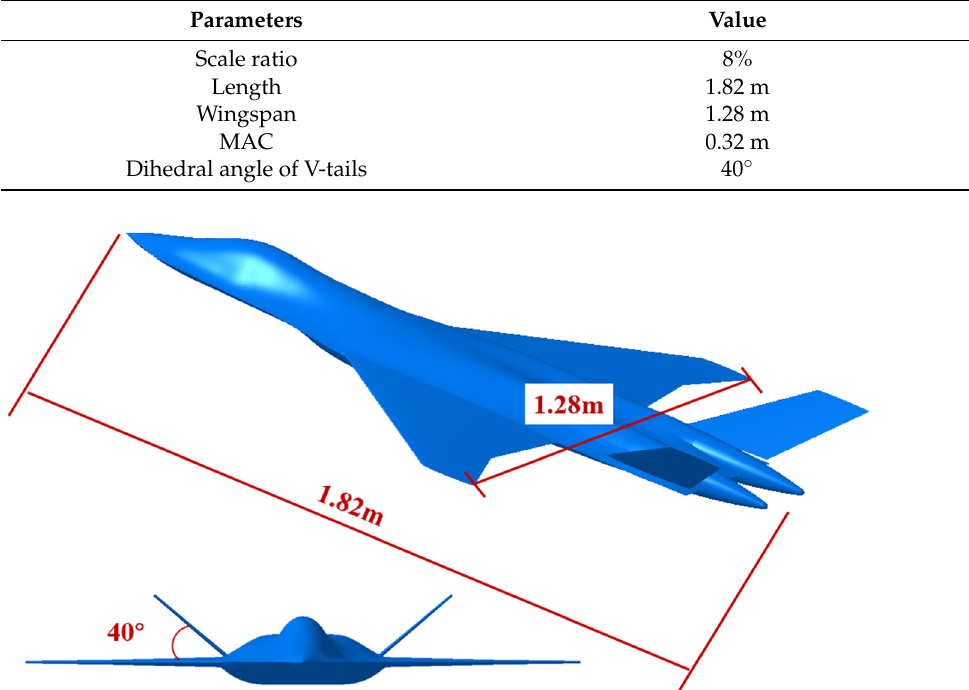
Figure 2. Aerodynamic shapes of the present aircraft.